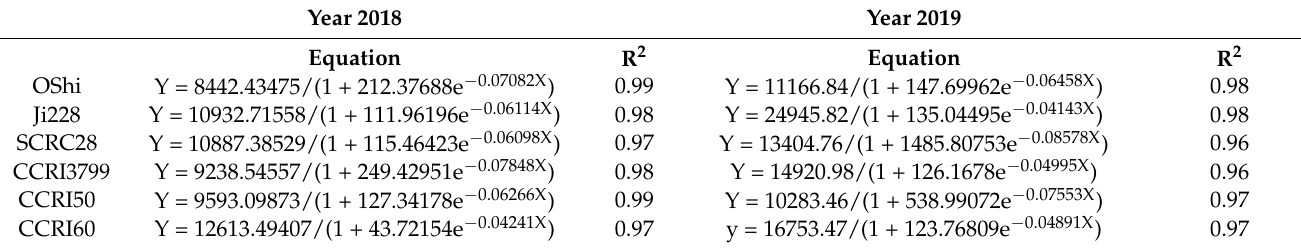
Table 4. Biomass accumulation simulation equation for six cultivars in 2018 and 2019: Y = K/(1 + ae bx ). Year